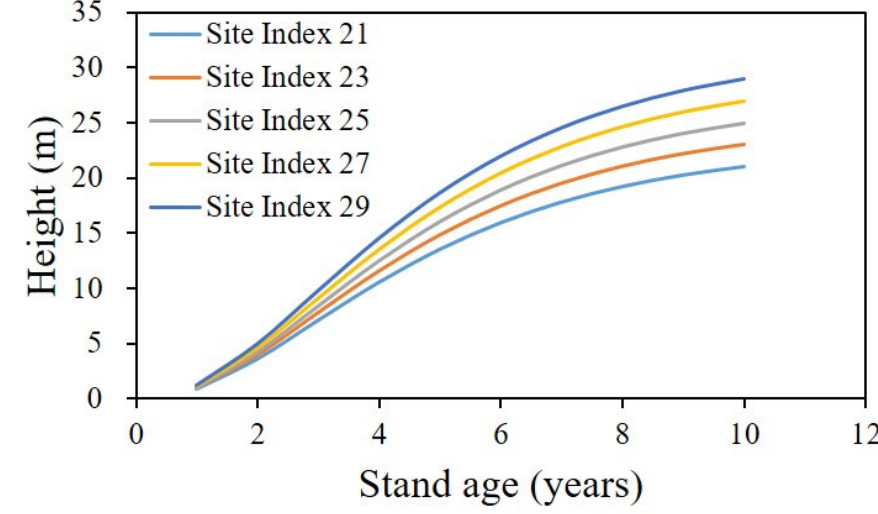
Figure 3. Site index classification curves for Acacia hybrid plantations in Vietnam.